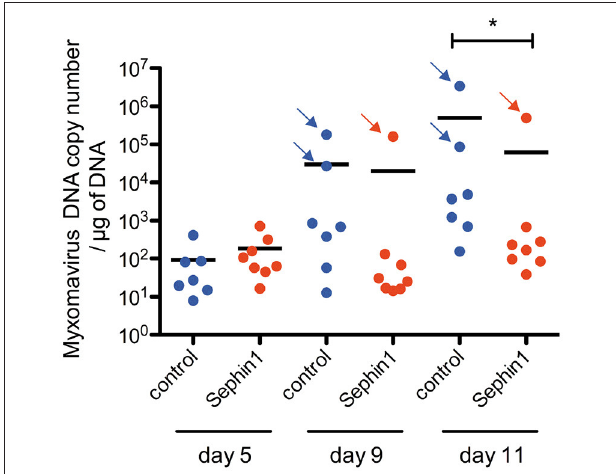
FIGURE 11 | Evaluation of the antiviral potential of Sephin1 against myxoma virus in vivo. Rabbits were inoculated with 50 plaque-forming units of myxoma virus. Eight rabbits were treated with Sephin1 by oral gavage once daily at a dose of 5 mg/kg. Seven rabbits were administered vehicle only. Myxoma virus DNA was detected by q-PCR from conjonctival swabs performed at the indicated days post-infection. Rabbits exhibiting clinical signs are indicated with an arrow. * p < 0.05 by the two-tailed Mann–Whitney